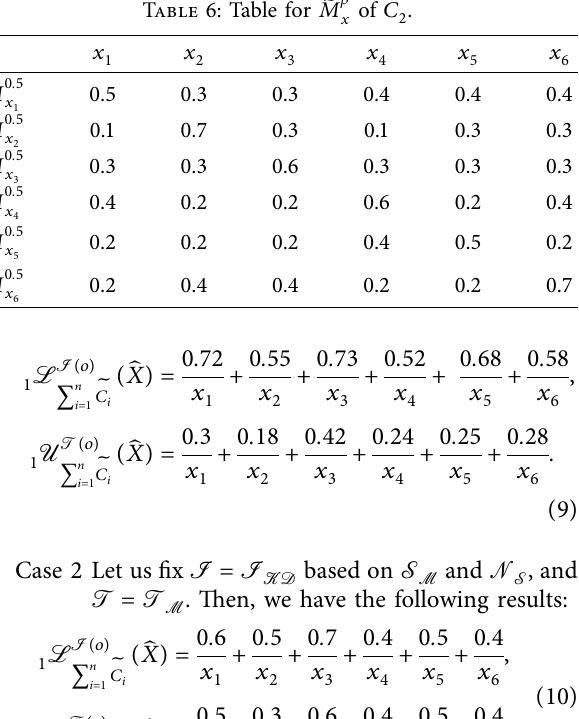
Table 6: Table for 􏽥 M β